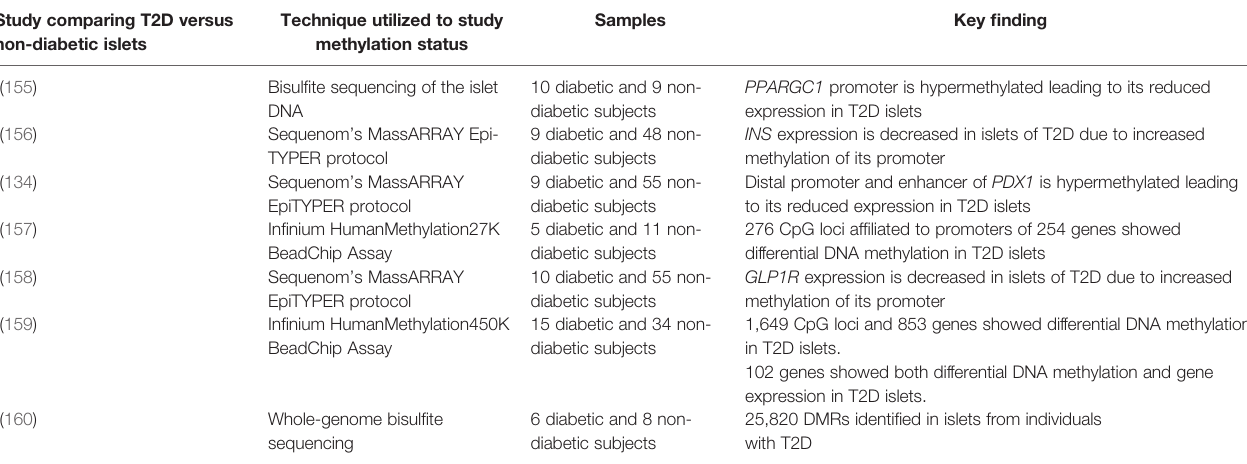
TABLE 1 | DNA methylation studies in islets from T2D subjects, techniques utilized, and the key fi ndings. Study comparing T2D versus non-diabetic islets